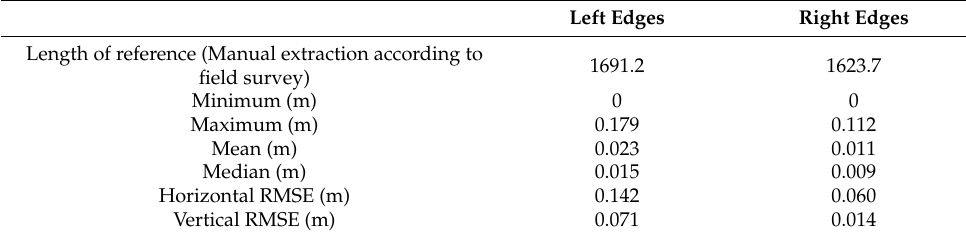
Table 3. Parameters after overlaying the manually extracted. Left Edges Right Edges Length of reference (Manual extraction according to field